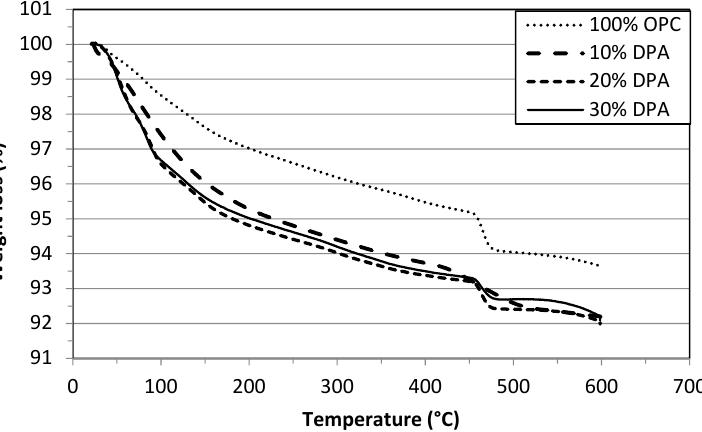
Figure 6. TGA curve at the age of 28 days.